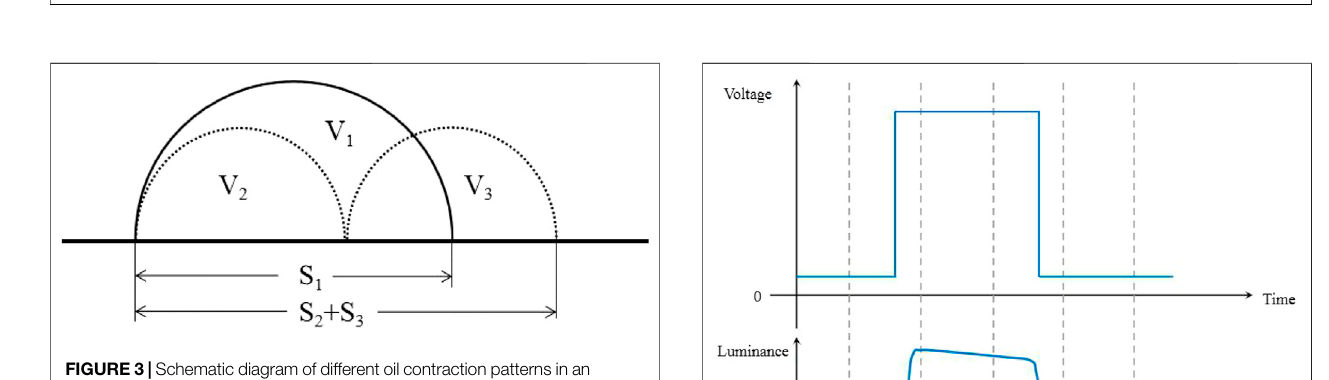
FIGURE2| DisplayprincipleofanEWDpixel. (A) Ahomogeneousoil fi lmispresentwhennodrivingvoltageisapplied,andthepixelisincoloredoff-state. (B) When a driving voltage is applied, oil is shrunk to a corner, and the pixel is in white on-state. (C) Top view of the pixel in colored off-state. (D) Top view of the pixel in white on- state.